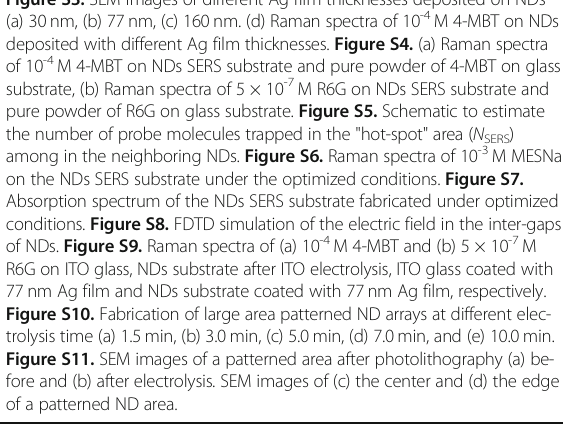
Figure S3. SEM images of different Ag film thicknesses deposited on NDs (a) 30nm, (b) 77nm, (c) 160nm. (d) Raman spectra of 10 -4 M 4-MBT on NDs deposited with different Ag film thicknesses. Figure S4. (a) Raman spectra of 10 -4 M 4-MBT on NDs SERS substrate and pure powder of 4-MBT on glass substrate, (b) Raman spectra of 5 × 10 -7 M R6G on NDs SERS substrate and pure powder of R6G on glass substrate. Figure S5. Schematic to estimate the number of probe molecules trapped in the "hot-spot" area ( N SERS ) among in the neighboring NDs. Figure S6. Raman spectra of 10 -3 M MESNa on the NDs SERS substrate under the optimized conditions. Figure S7. Absorption spectrum of the NDs SERS substrate fabricated under optimized conditions. Figure S8. FDTD simulation of the electric field in the inter-gaps of NDs. Figure S9. Raman spectra of (a) 10 -4 M 4-MBT and (b) 5 × 10 -7 M R6G on ITO glass, NDs substrate after ITO electrolysis, ITO glass coated with 77nm Ag film and NDs substrate coated with 77nm Ag film, respectively. Figure S10. Fabrication of large area patterned ND arrays at different elec- trolysis time (a) 1.5min, (b) 3.0min, (c) 5.0min, (d) 7.0min, and (e) 10.0min. Figure S11. SEM images of a patterned area after photolithography (a) be- fore and (b) after electrolysis. SEM images of (c) the center and (d) the edge of a patterned ND